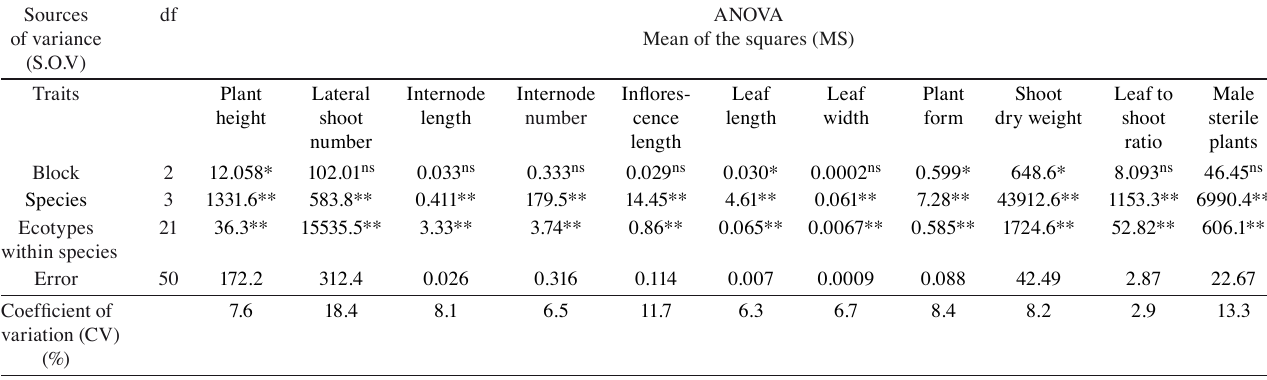
Tab. 2: Analysis of variance (ANOVA) of morphological traits in thyme species and ecotypes. Sources df